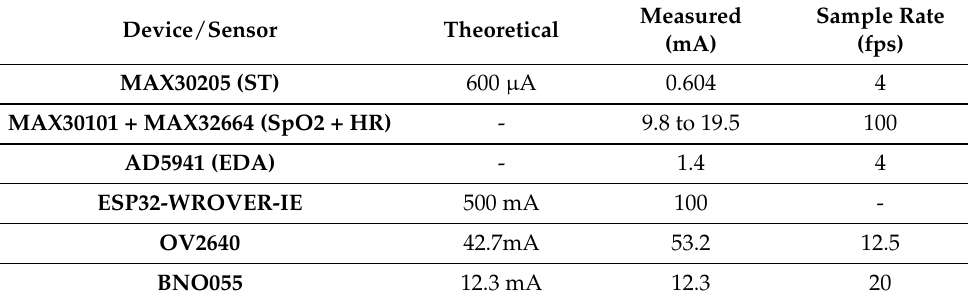
Table 2. Sensors and main power consumption